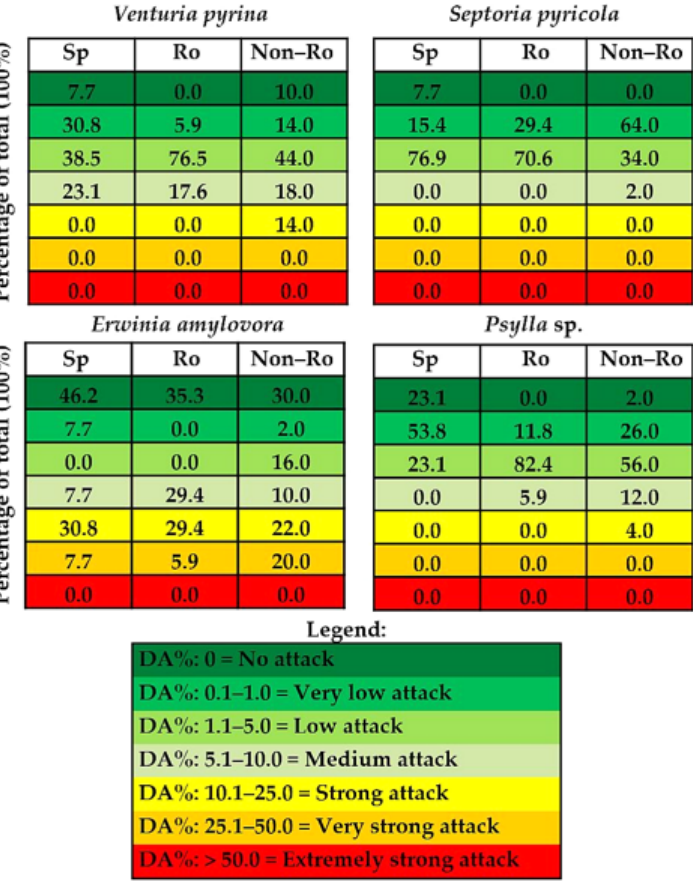
Figure 3. Classification of pear genotypes from the three groups containing 13 species (Sp), 17 Romanian cultivars (Ro), and 50 non-Romanian cultivars (Non-Ro), in attack classes according to the values for degree of attack ( DA %). Data represent the percentage values of each class from the total genotypes (100%) based on DA% of the pear scab ( V. pyrina ), septoria ( S. pyricola ) , fi re blight ( E. amylovora ), and psylla ( Psylla sp.).